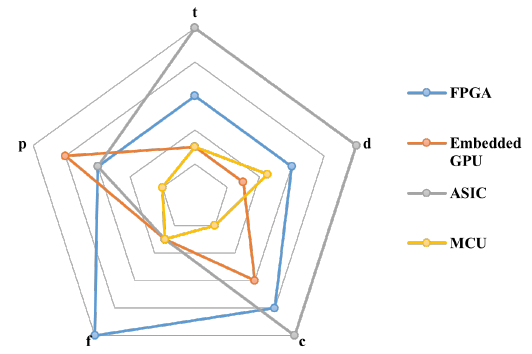
Figure 5. Comparison of platforms on five aspects. FPGA shows great merits in Flexibility, which is important in further research. Other platforms also show excellent performance in accelerating neural network inference, but mainly rely on developed